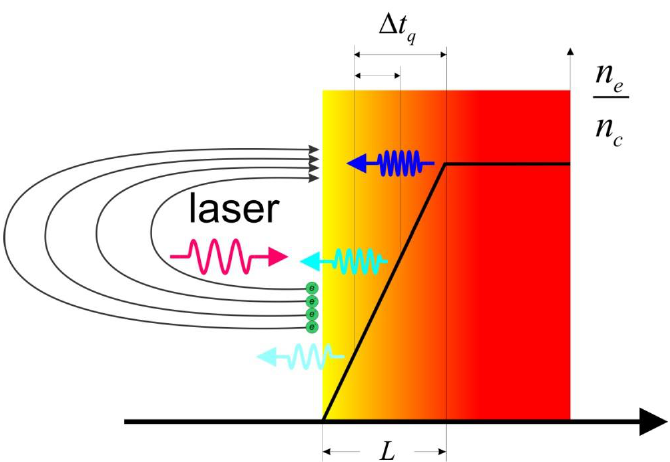
Figure 2. Schematic showing the basic idea of the coherent wake emission mechanism.